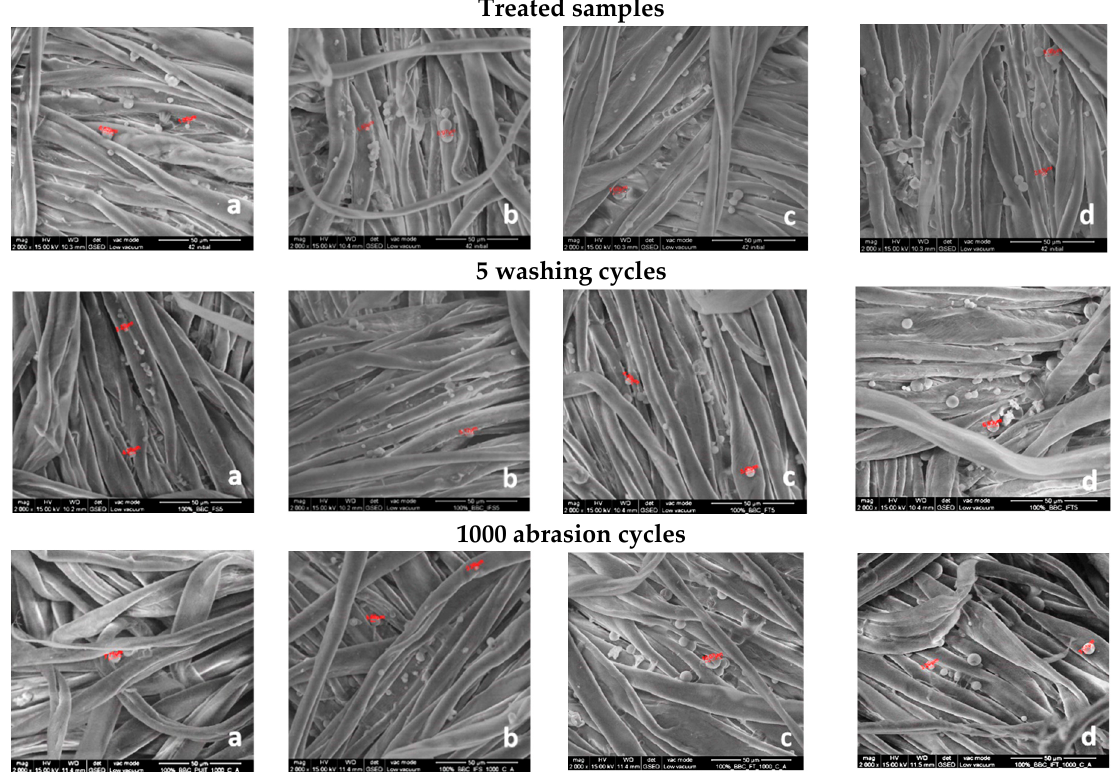
Figure 1. SEM images recorded at 2000× magnification for 100% cotton fabrics treated in different experimental variants with sage (S) and rose (R) microcapsules: ( a ) 1V 1 S, ( b ) 1V 2 S, ( c ) 1V 1 R, ( d ) 1V 2 R.